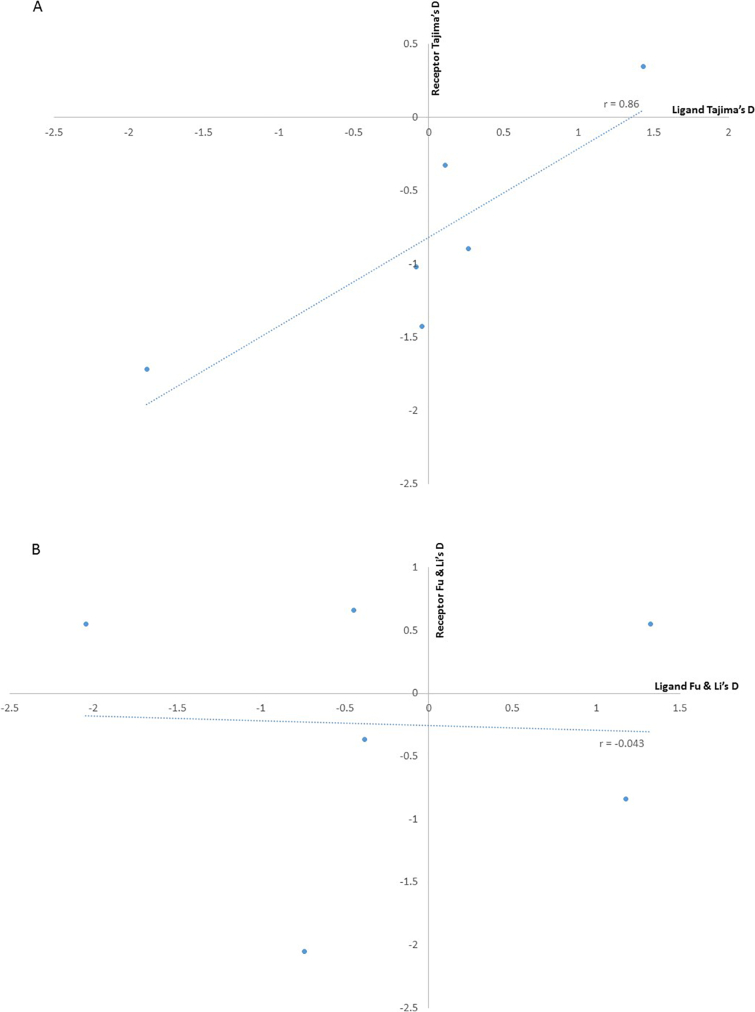
Scatter plot showing the correlations between the summary statistics indices for each erythrocyte receptor-merozoite ligand pair. The merozoite ligand Tajima's D value was plotted against its erythrocyte receptor Tajima's D value, the same was done for the Fu & Li D* and F* plots. The values used from the erythrocyte receptors with data from more than one exon were as follows: for band 3 the average of both exons 17 and 18 plotted against MSP1–19 since it is the region that primarily interacts with the receptor, BSG only exon 5 was considered since previous literature has shown altering codon 90 lowers binding (Crosnier et al., 2011) and it was plotted against Rh5, Gyp B- was an average of exons 2 and 3, similar to Gyp A for which exons 2 and 3 are considered to be involved in binding EBA175, plotted against EBL-1 regions and Gyp A exon 2 was plotted against EBA175. (A) Shows the correlation of the Tajima's D statistic for each receptor-ligand pair, (B) the correlation of the Fu & Li’s D* statistic for each receptor-ligand pair and (C) is the correlation of the Fu & Li’s F* statistic for each receptor-ligand pair. The Pearson product-moment correlation coefficient, r, is shown on the graphs.